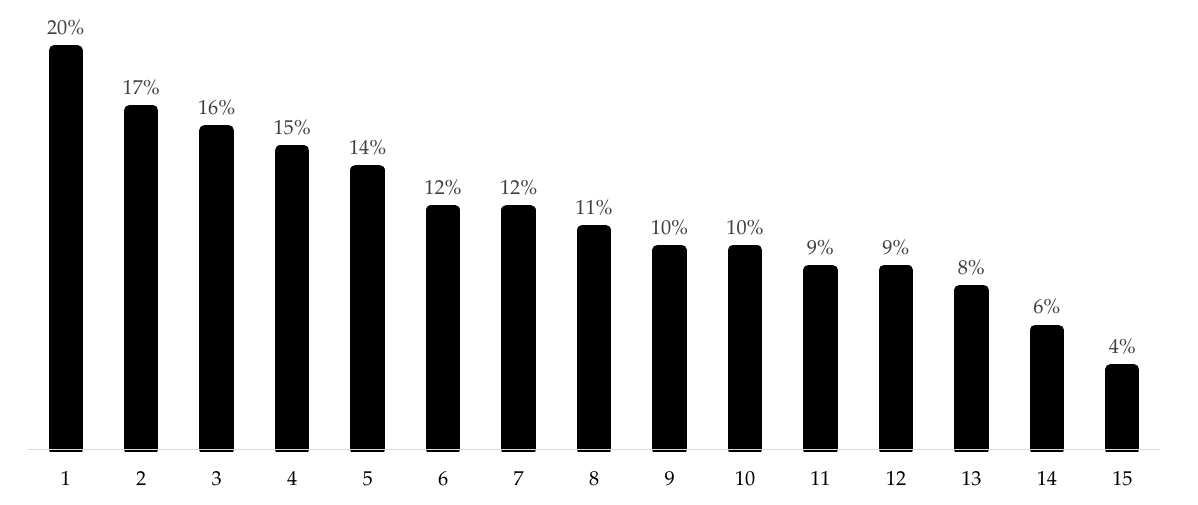
Figure 2. Prevalence of sedentary behavior counseling received from healthcare professionals by adults in each of the 15 basic health units evaluated. São José dos Pinhais, Paraná, Southern Brazil, 2019 (n = 779). The mean of SB was 4.26 ± 3.47 h/day, highest in watching TV (1.88 ± 2.0 h/day) and lowest in studying (0.23 ± 0.87 h/day) (Table 2).